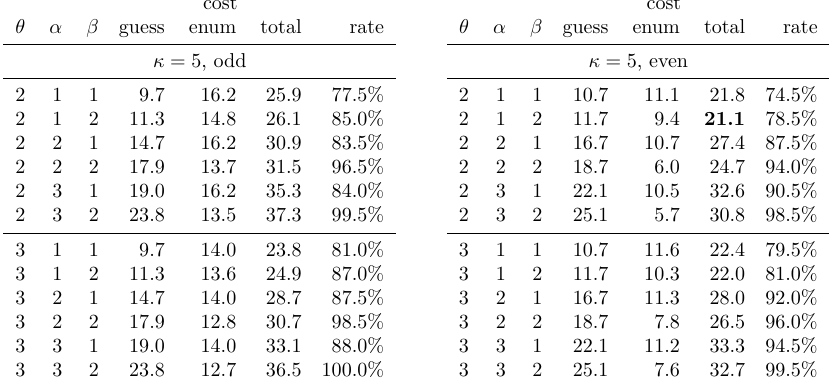
Table 7: Experimental results for Kyber parameters and number of bit-flips κ = 5 ( ρ 0 = 0 . 2%, ρ 1 = 0 . 1%); θ is the scaling factor of our lattice, α the number of bits we guess in a band of size β . In the “even” case we target the least significant bits of the components of ∆ first. The column “guess” holds the number of guesses before lattice enumeration which includes the cost of guessing ∆ 0 , the column “enum” holds the number of nodes in the pruned lattice-point enumeration tree. The column “total” is the product of the two. All costs are give as log ( · ). The column “rate” is the success rate over 200 2 experiments. Only parameters with success rate ≥ 60% are shown. The minimal total cost is highlighted in bold and used in Table